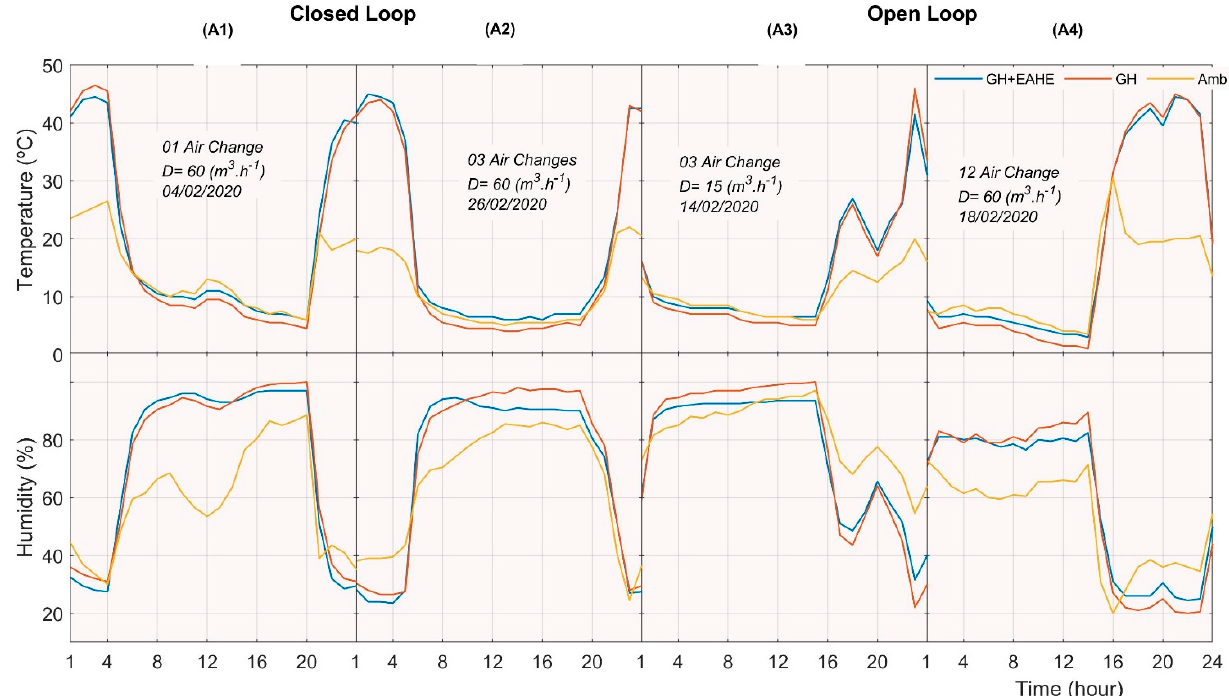
Figure 4. GHs air temperature/humidity variation during the experiences periods (heater device: Off).